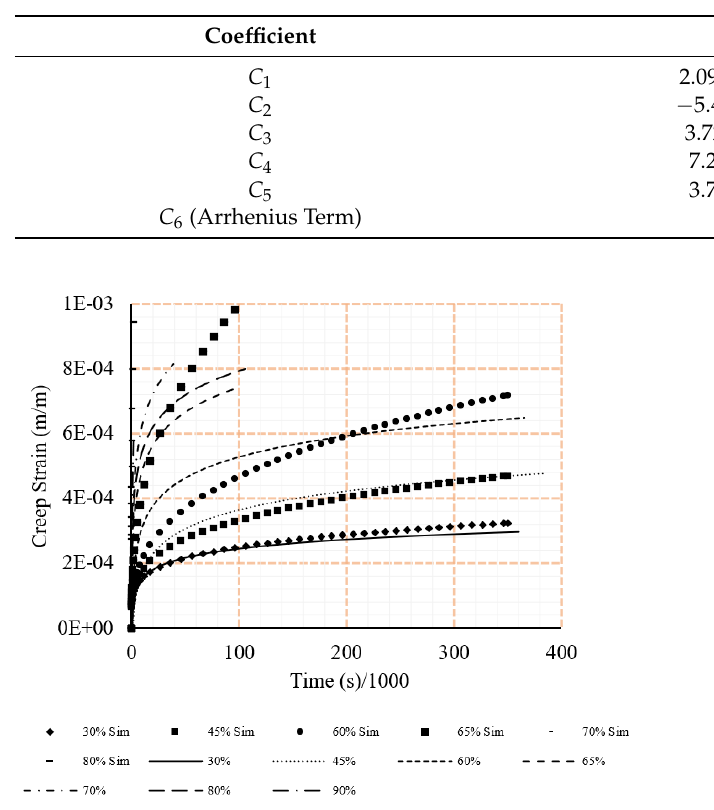
Figure 8. Comparison between experiment and simulation tensile strains under different loading rations (ratio of sustained load to the ultimate load).